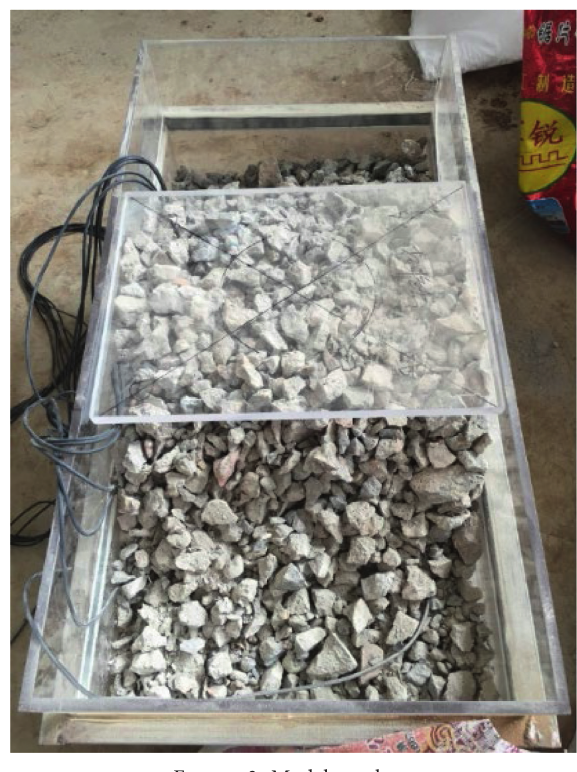
Figure 3: Model test